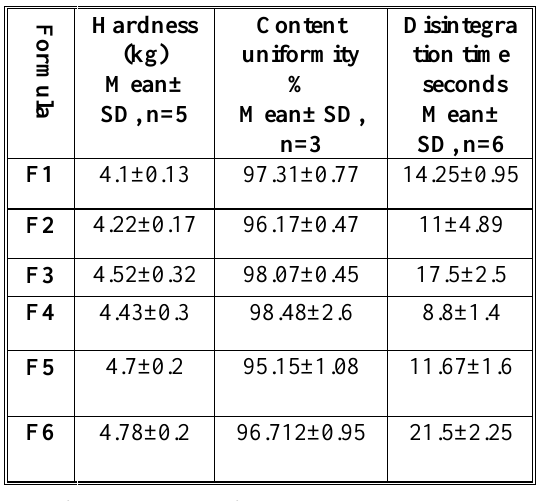
Table 5 . Physical evaluation of core tablets of sumatriptan